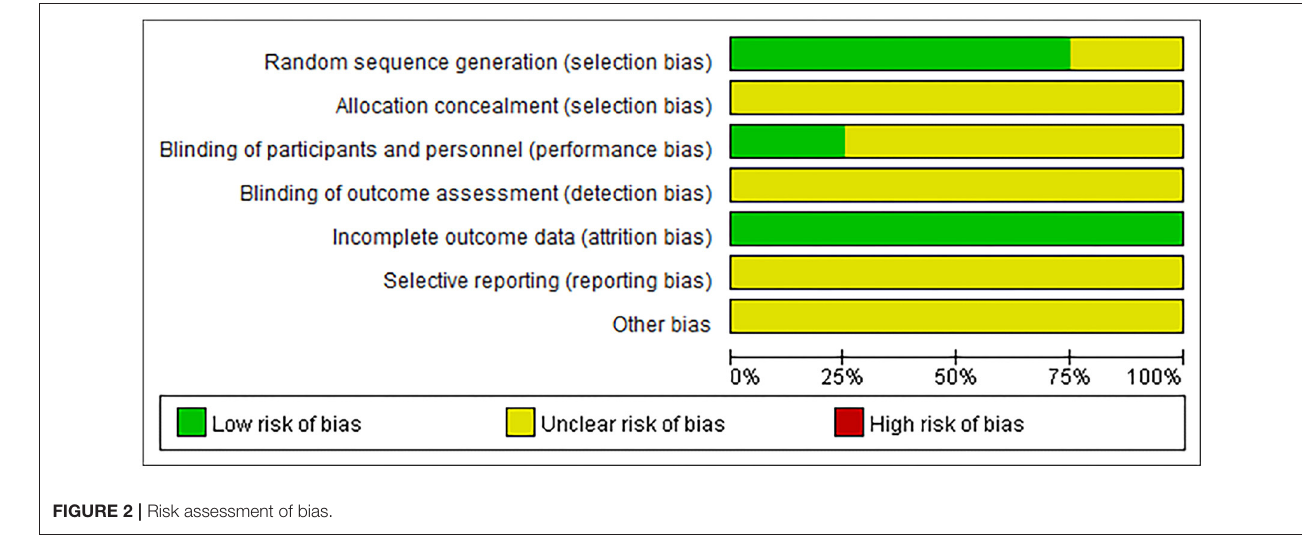
FIGURE 2 | Risk assessment of bias.